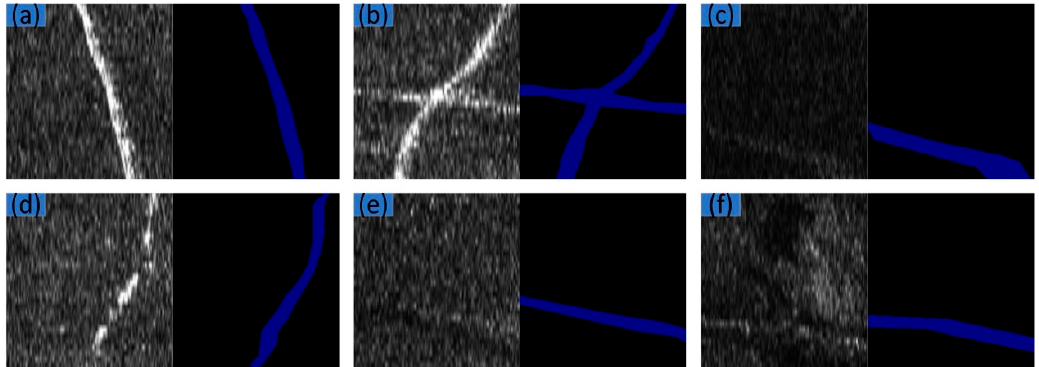
Figure 6. Examples of SSS image: ( a ) Clear and standard; ( b ) some target pixels are obvious and others are weak; ( c ) dark; ( d ) discontinuous; ( e ) weak and unclear; ( f ) noises.